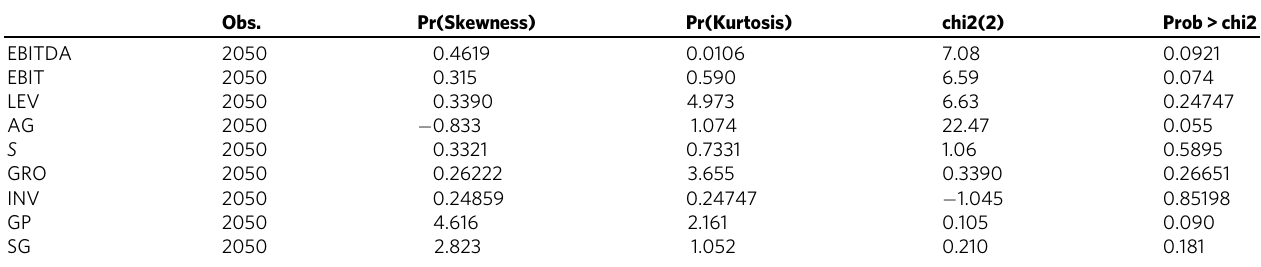
Table 4 Results of Skewness/Kurtosis tests.